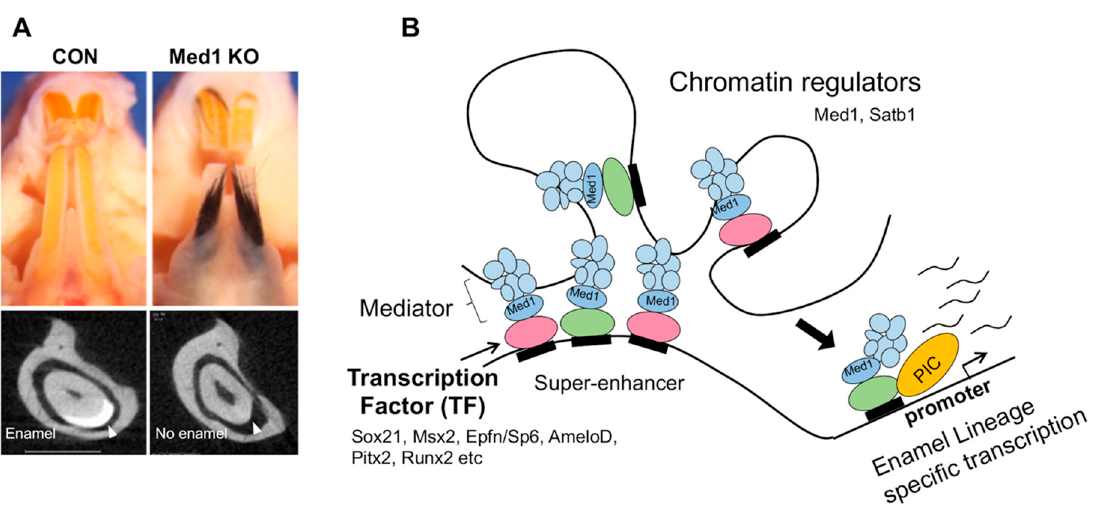
Figure 3. ( A ) Med1 KO mice generate hairs in incisors while disrupting enamel formation. ( B ) A proposed model to illustrate a role of transcription factors and chromatin regulators to control